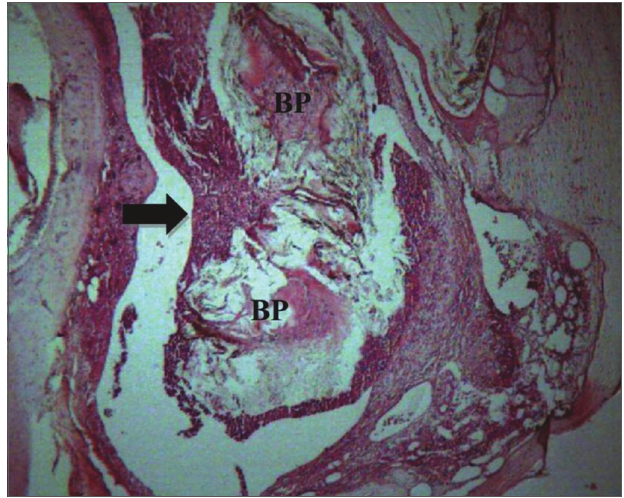
Figura 2. Grupo experimental com 4 semanas - Fotomicrografia do exsudado subagudo de grau moderado ao redor da membrana